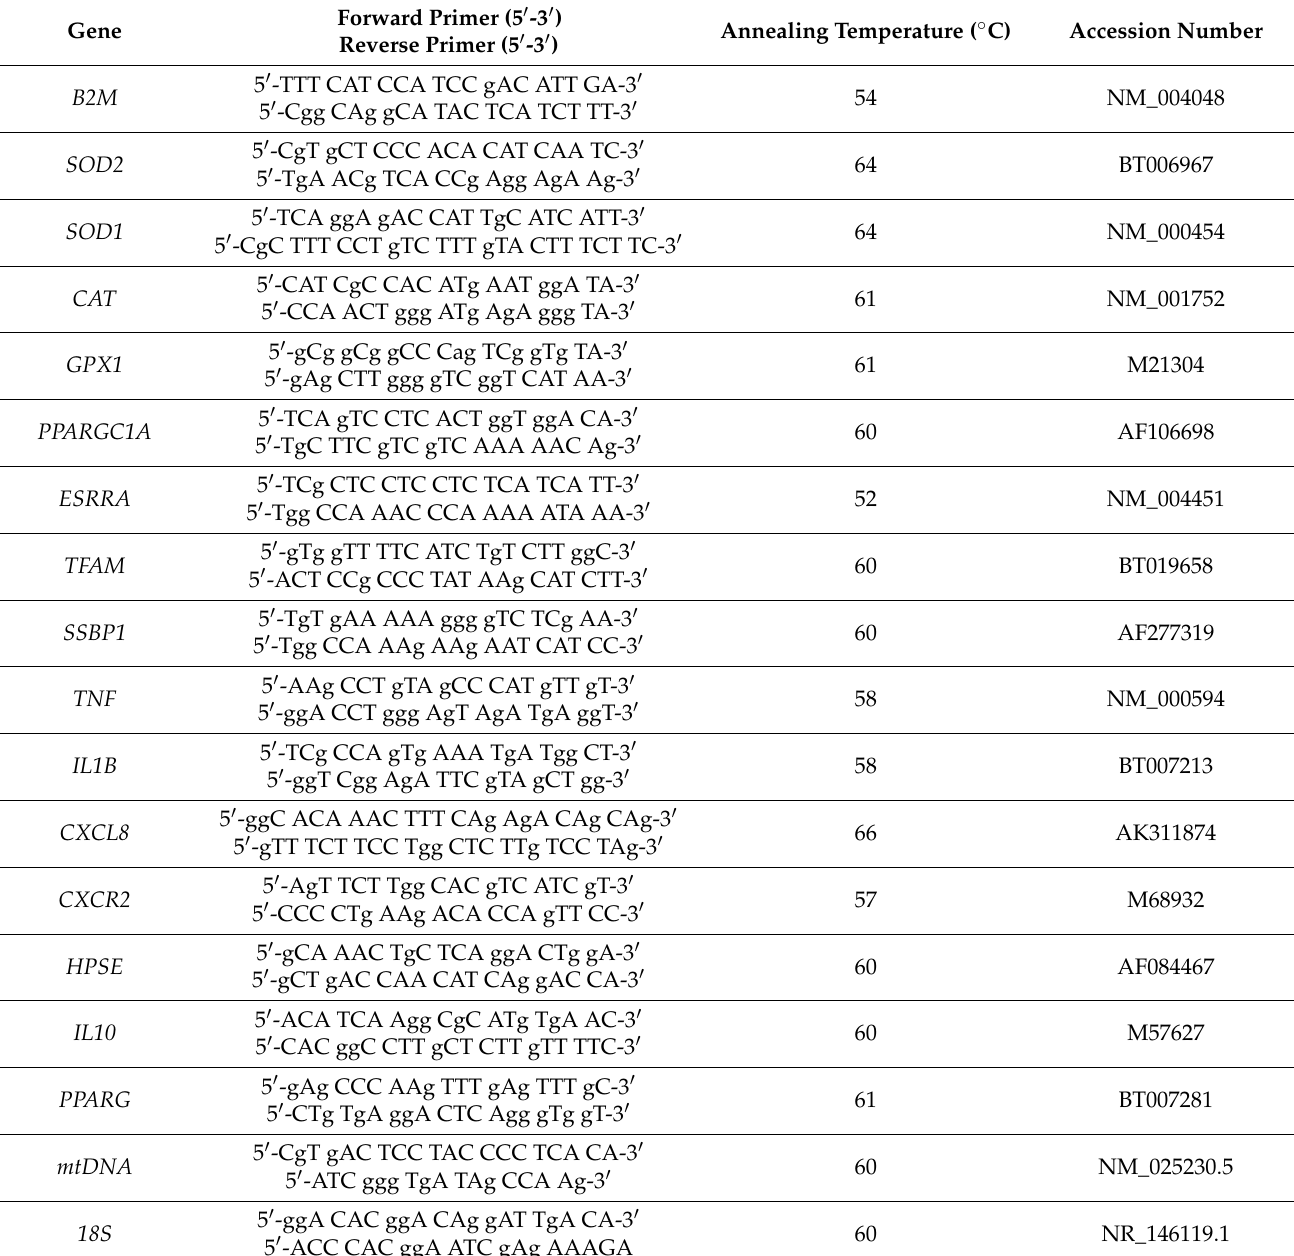
Table 1. Primers sequences and their respective annealing temperatures and accession